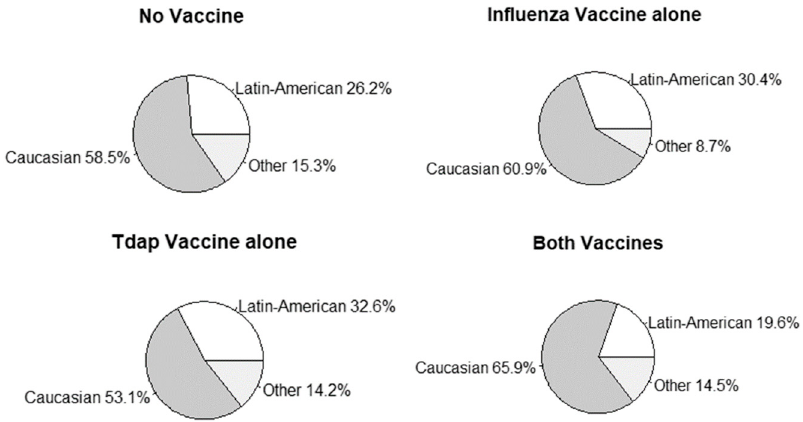
Figure 2. Ethnicity distribution by vaccination group.